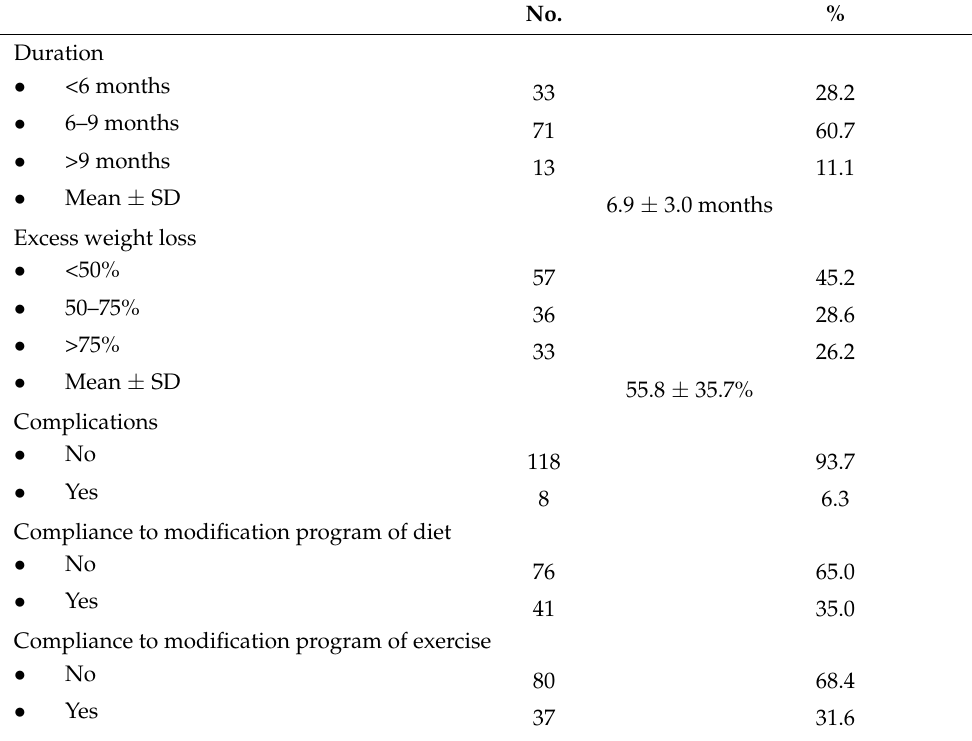
Table 2. Data related to IGB balloon and post-insertion patients’ compliance. No.